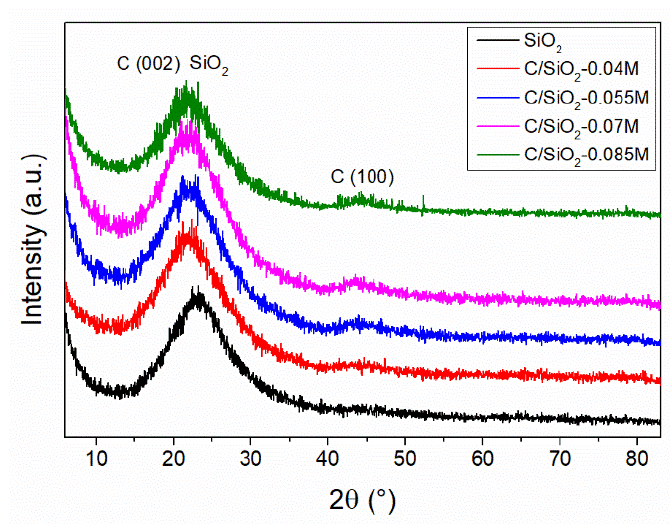
Figure 1. XRD patterns of silica and carbon–silica materials.